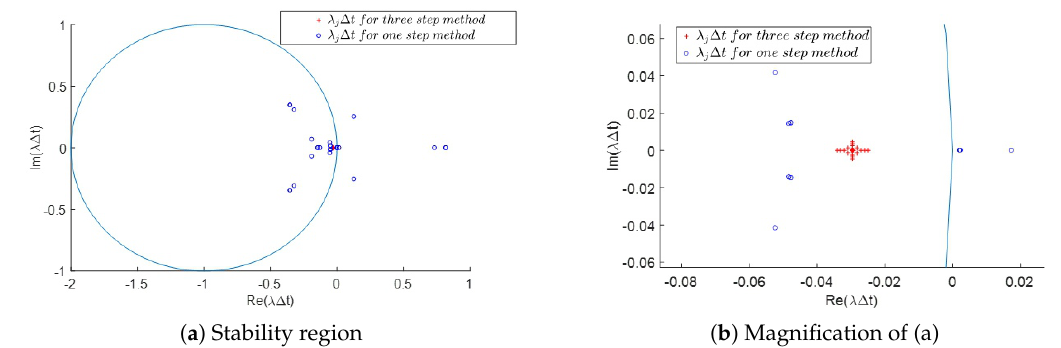
Figure 2. Stability region of Example 1 with the position of λ j ∆ t for M = 6, K = 2 and ∆ t = 0.01. ( b ) is obtained from the magnification of ( a ).